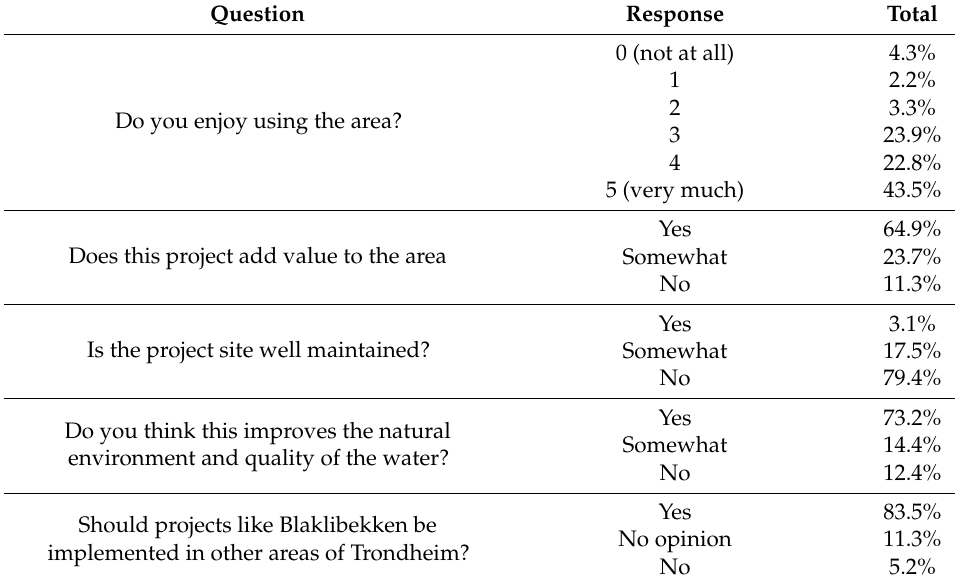
Table 2. Responses regarding site impressions and